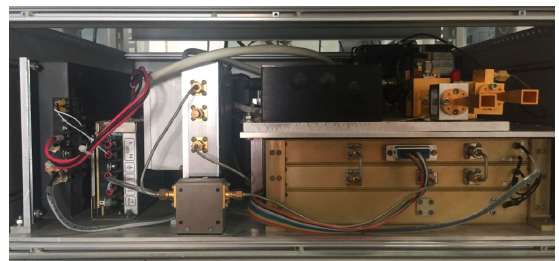
Figure 1. Photograph of the front-end setup.